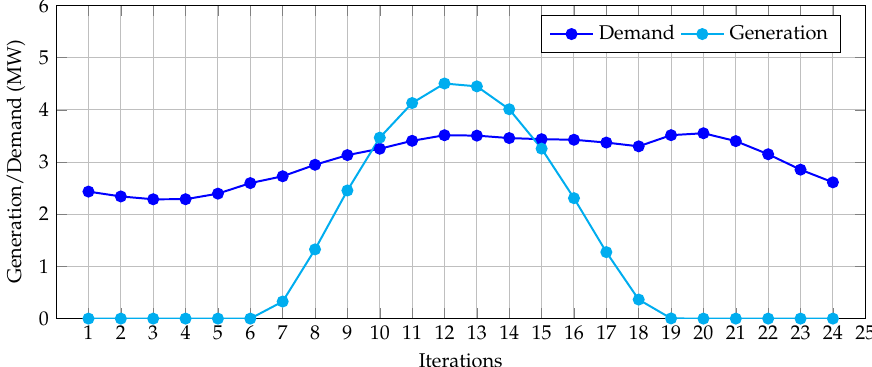
Figure 4. Behavior of the aggregated daily demand and generation